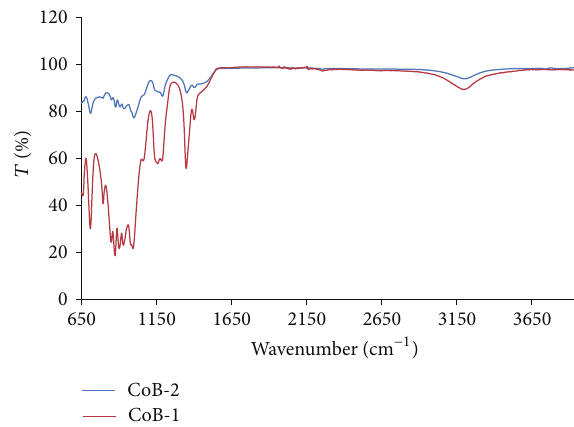
Figure 4: The FT-IR spectrum of Co-B catalysts.